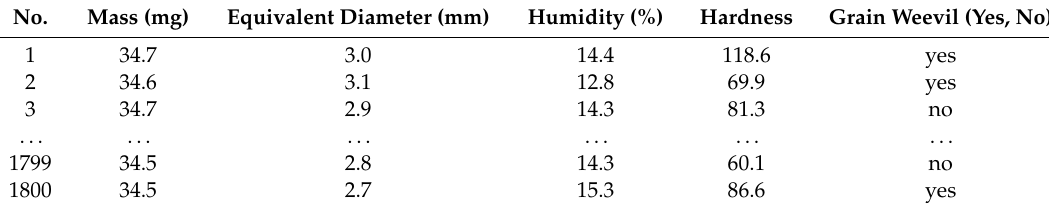
Table 1. Part of a training